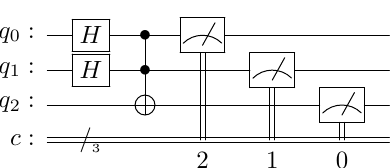
Figure 4. Quantum circuit for the AND operation. After the measurement, we have close to 25% for each of the possible outcomes, which is what we expected. Figure 5 shows the outputs obtained after running the program 1000 times in the IBM quantum simulator